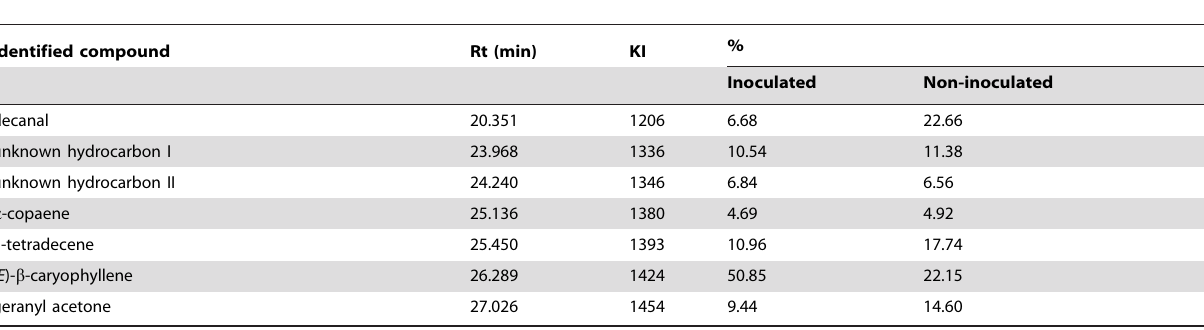
Table 1. Identification of compounds in the root volatile profile.